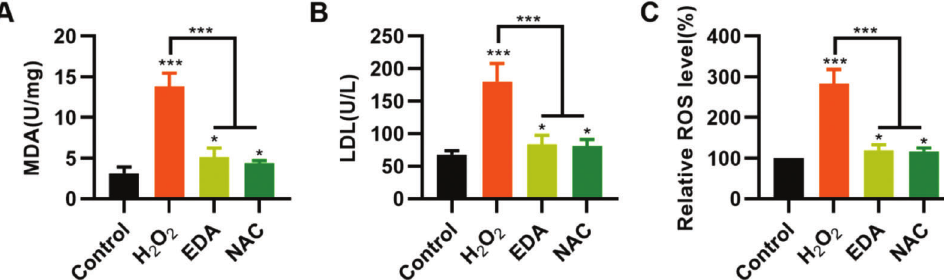
Figure 2 - Edaravone (EDA) inhibits the oxidative stress in nerve stem cells (NSCs). A, Malondialdehyde content in the medium of NSCs; B, Lactic dehydrogenase content in the medium of NSCs; C, reactive oxygen species content in the medium of NSCs. * p o 0.05, *** p o 0.001. Mann–Whitney U test (A–C).